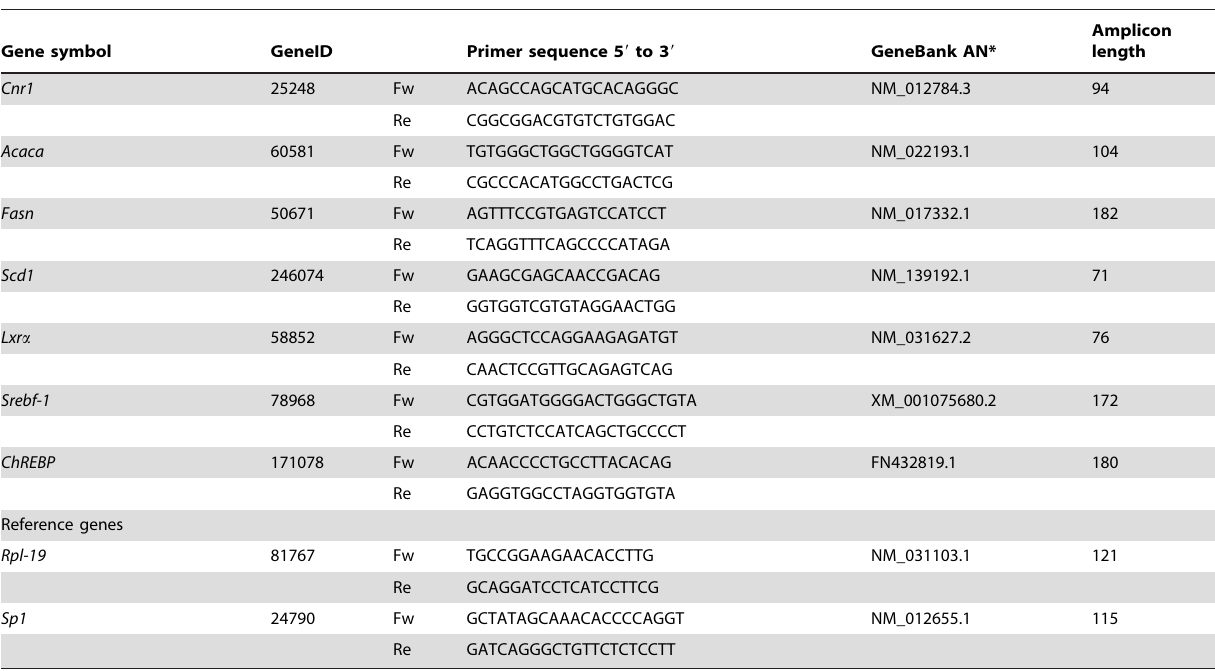
Table 1. Primer sequences used for real-time quantitative PCR.